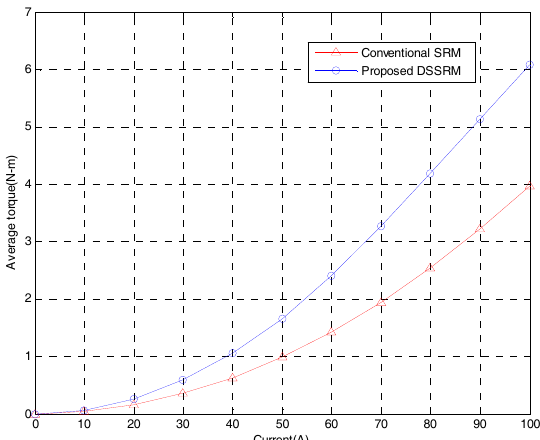
Figure 27. Torque profile of proposed DSSRM.